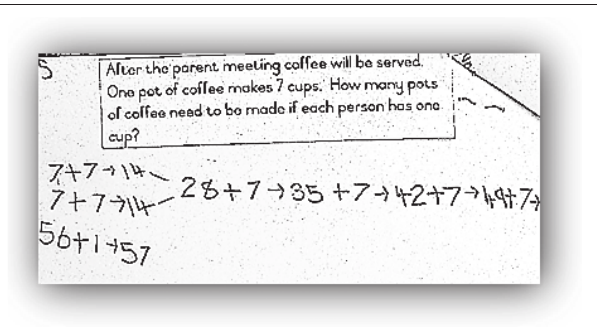
FIGURE 10: Gemma (Intervention-Problem 8).